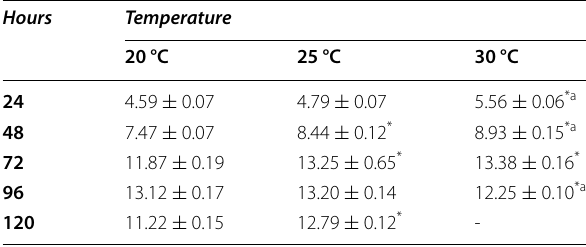
Data represented as mean SE, n 30. Significance at 0.5 level represented by ± = asterisk (*) as compared with body length at 20 °C; a significance at 0.5 level as compared with weight at 25 °C within the same